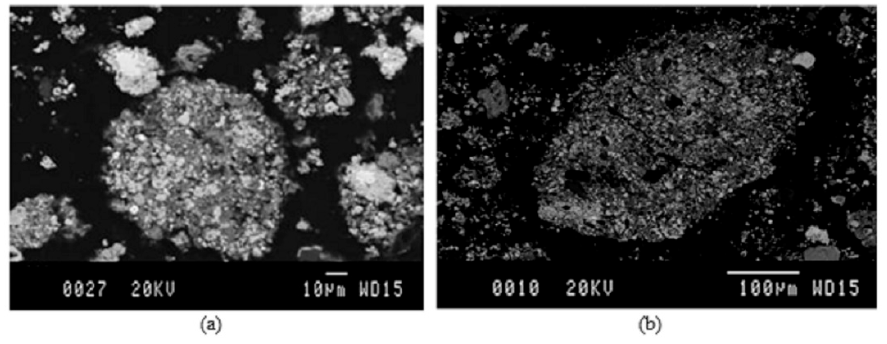
Figure 8. Representative areas of anode slime ClO − /OH − ( × 600). ( a ) the particle size is between 10 µm and 50 µm, ( b ) The particle size is between 10 µm and 400 µm.